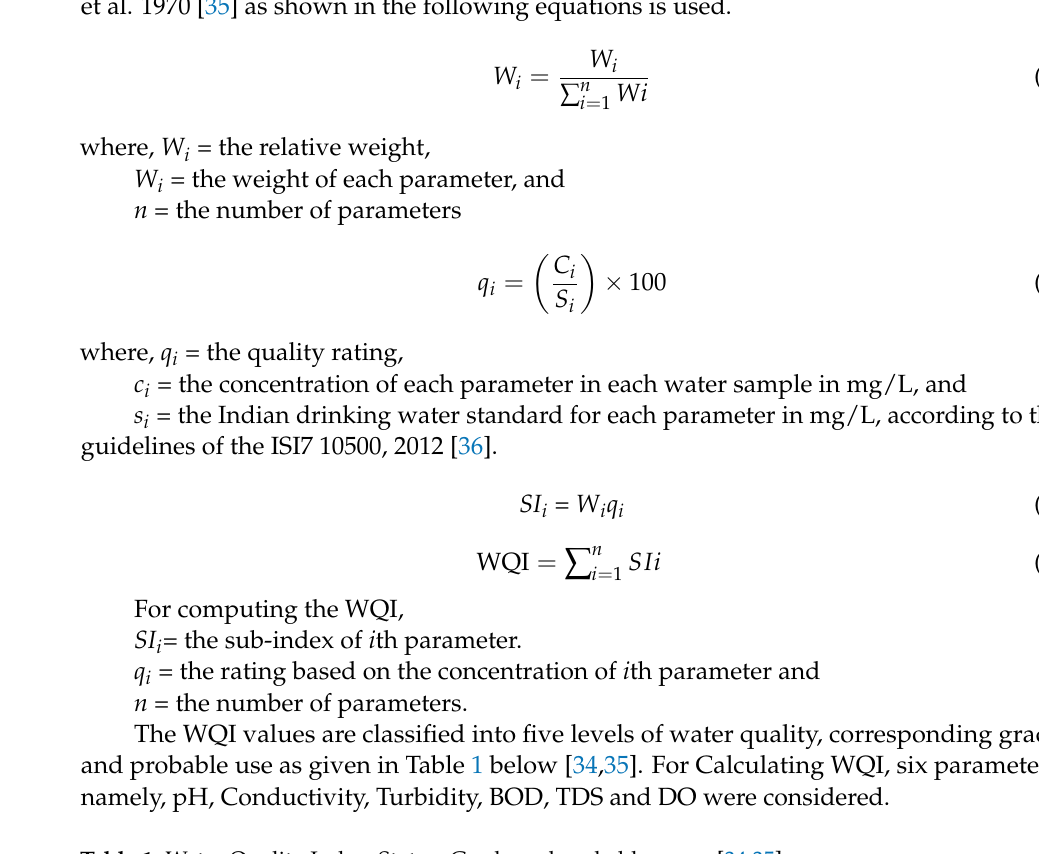
Table 1. Water Quality Index, Status, Grade and probable usage